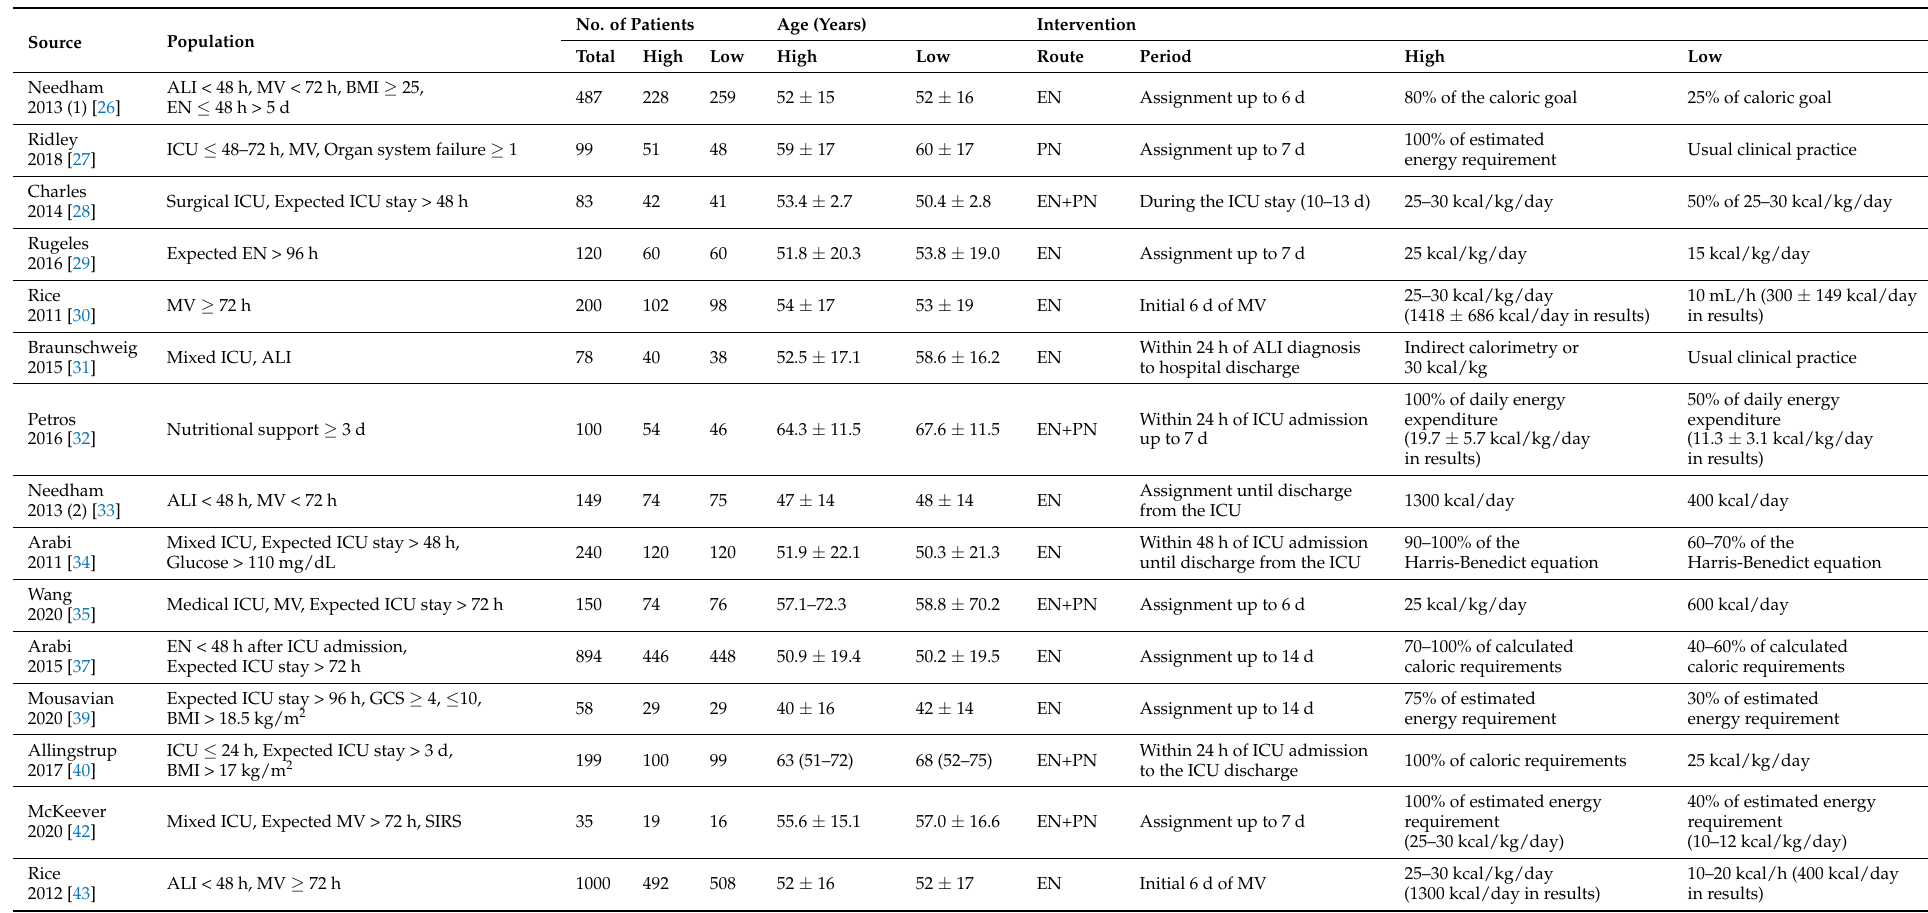
Table 1. Characteristics of included studies for optimal energy